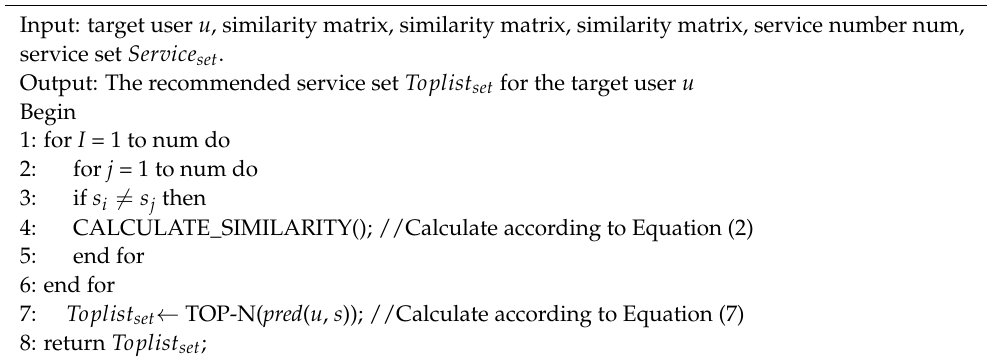
Algorithm 1 Design of Hybrid Recommendation Algorithm Fused with Knowledge